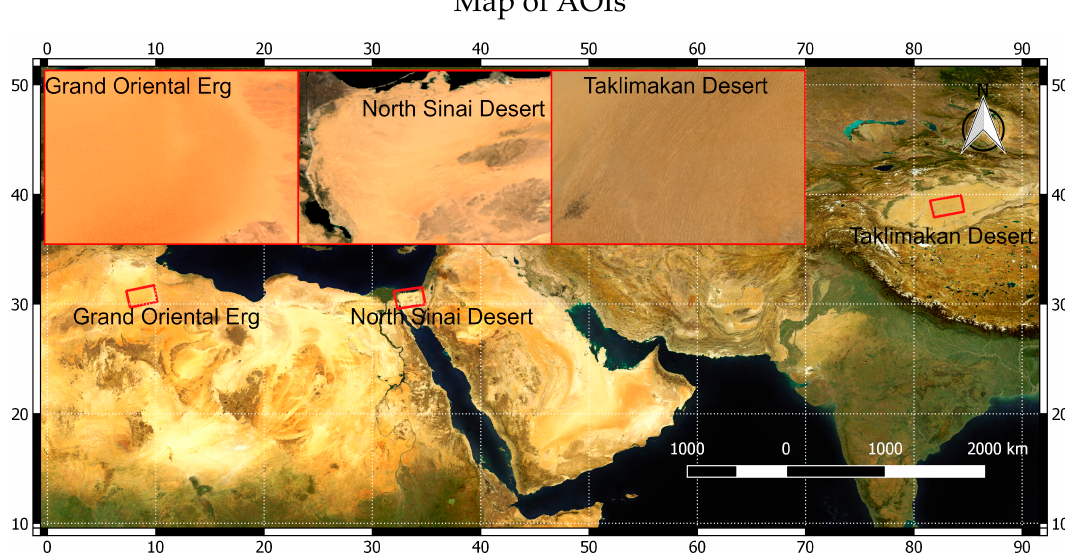
Figure 1. Map showing the location of areas of interest (AOIs) on an ENVISAT MERIS true colour mosaic, in a geographic latitude, longitude map system, World Geodetic System 1984 (WGS84) datum. Insets show a close–up of the AOIs. Each AOI and inset has the dimension of one Sentinel–1 IW footprint (250 km East–West, 170 km North–South). Credits: CHELYS srl for the world map and the European Space Agency (ESA) GlobCover for insets.